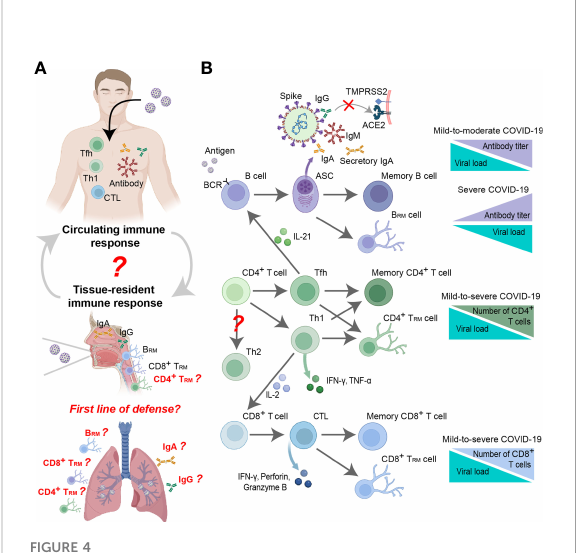
FIGURE 4 Antiviral mechanism of the adaptive immune response to SARS- CoV-2. (A) In vivo distribution of virus-speci fi c adaptive immune responses, including circulating and tissue-resident adaptive immune responses. The relationship between circulating immune responses and tissue-resident immune responses remains to be further investigated. The role of lung tissue- resident immune responses in the fi ght against SARS-CoV-2 infection is worth investigating. (B) Mechanisms of adaptive immune responses against SARS-CoV-2 and their relationship to disease